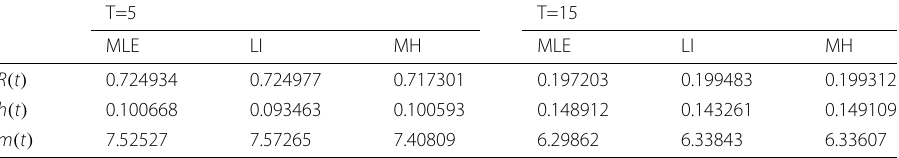
Table 7 Point estimates of R ( t ) , h ( t ) and m ( t ) for different choices of T from data set 1